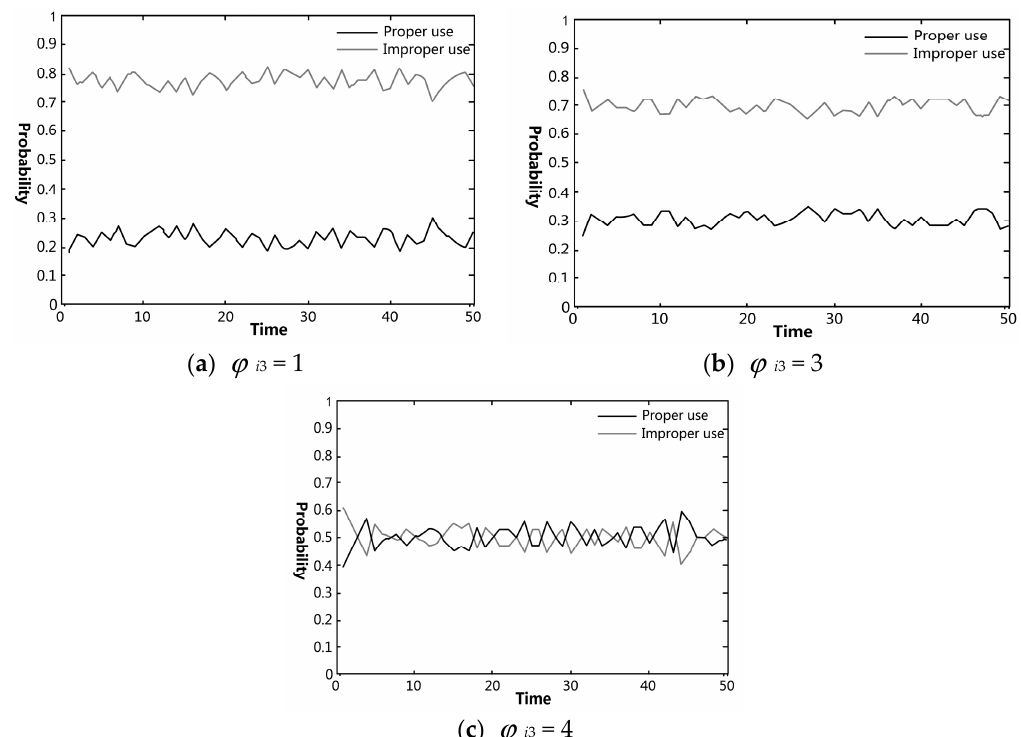
Figure 4. Simulation results of the changes of farmers’ behavioral choices regarding VA use under the variation of their knowledge about relevant laws and their penalties: ( a ) the value of ϕ i 3 (knowledge of relevant laws and their penalties) was set to 1; ( b ) the value of ϕ i 3 was set to 3; ( c ) the value of ϕ i 3 was set to 4.